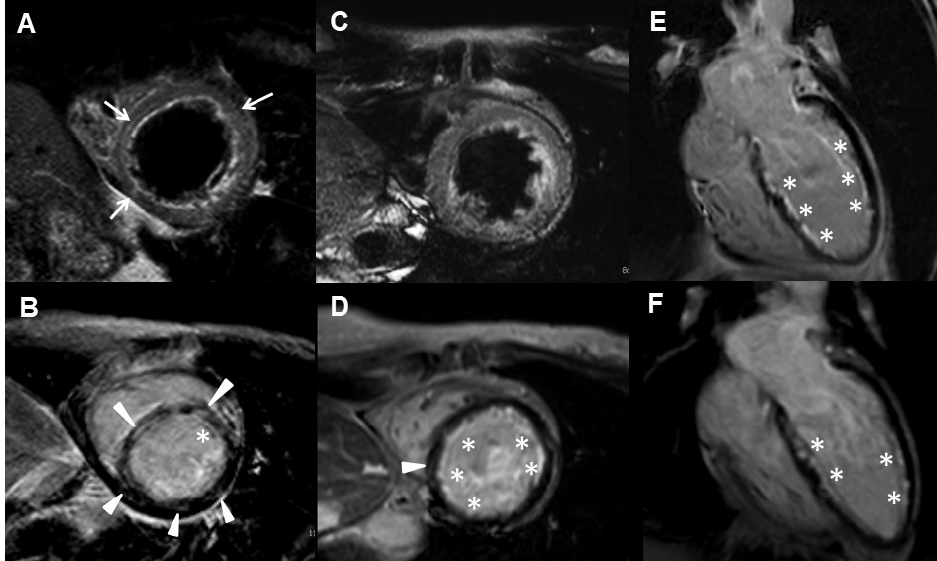
Figure 3. Serial cMRI images in case no. 3 before and after RTX therapy. ( A , B ) Pre-RTX treatment cMRI images revealed mid-wall edema in short-axis T2-weighted images ( A , white arrows) and post-gadolinium delayed enhancement images ( B , white arrowheads). Regional endocarditis in the anterior wall at LV mid-cavity ( B , asterisk). ( C – E ) After induction therapy, follow-up images showed resolved myocardial edema ( C ), some mid-wall fibrosis ( D , white arrowheads) and interval worsening of endocarditis ( D , E , asterisks) seen from short-axis and 4-chambered sections. ( F ) The endocardial change revealed improvement after two courses of maintenance therapy ( F , asterisks).